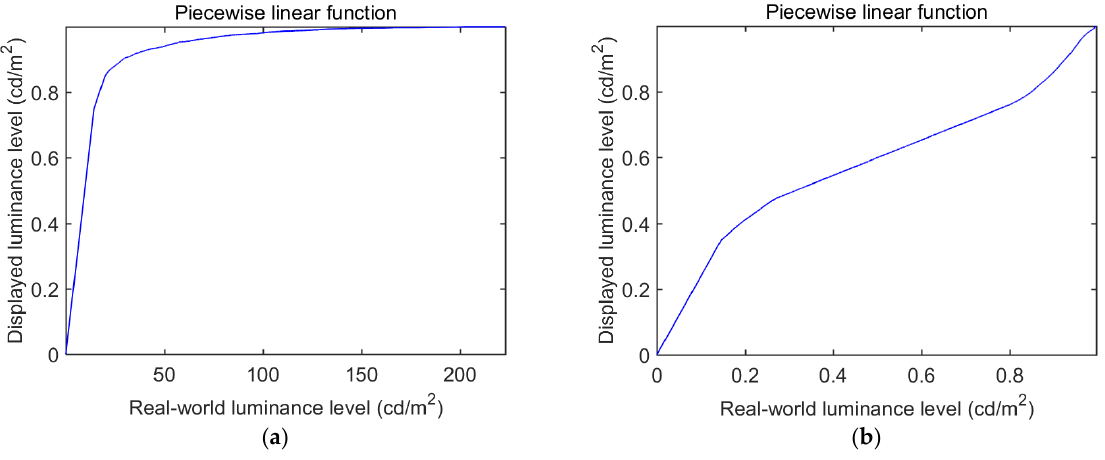
Figure 2. Piecewise linear function. ( a ) Memorial Church; ( b ) Moto.